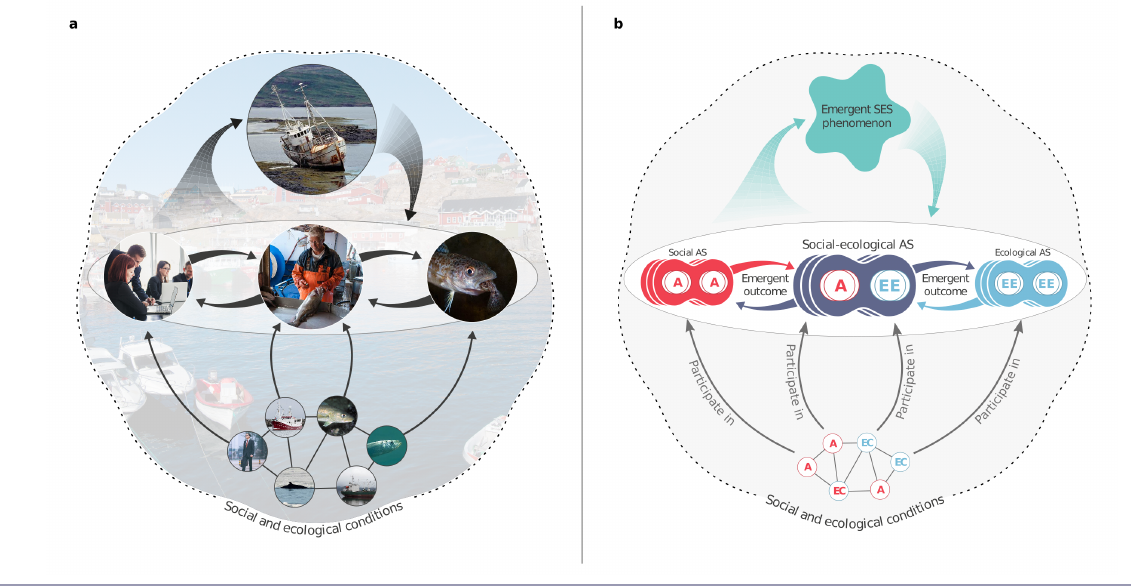
Fig. 1 . The emergence of a social-ecological phenomenon (emergent SES phenomenon) from social-ecological interactions. (a) The collapse of a fishery (a type of regime shift, top picture) emerges from interactions between fishers and the fish through fishing (middle circle), policymakers that devise incentives and regulations (left circle), and different fish and other species that interact through a food web (right circle). The framework is used to abstract these action situations from the many relations and interactions between actors and ecosystem components in a given SES, represented by the network of actors and ecological entities at the bottom of the figure. Emergent outcomes from one AS, such as regulations, affect interactions in another AS, e.g., fishing. (b) The generic SE-AS framework. The eclipse in the middle represents a configuration of AS that are hypothesized to have generated the emergent SES phenomenon of interest. There can be multiple social, social-ecological, and ecological AS in a configuration. This configuration is developed by identifying those social-ecological, social, and ecological AS from the many interactions in the SES (network in the bottom) that are considered relevant from a theoretical or empirical perspective. The emergence of the phenomenon results from a continuous process of local interactions that shape emergent outcomes to which they subsequently adapt (green